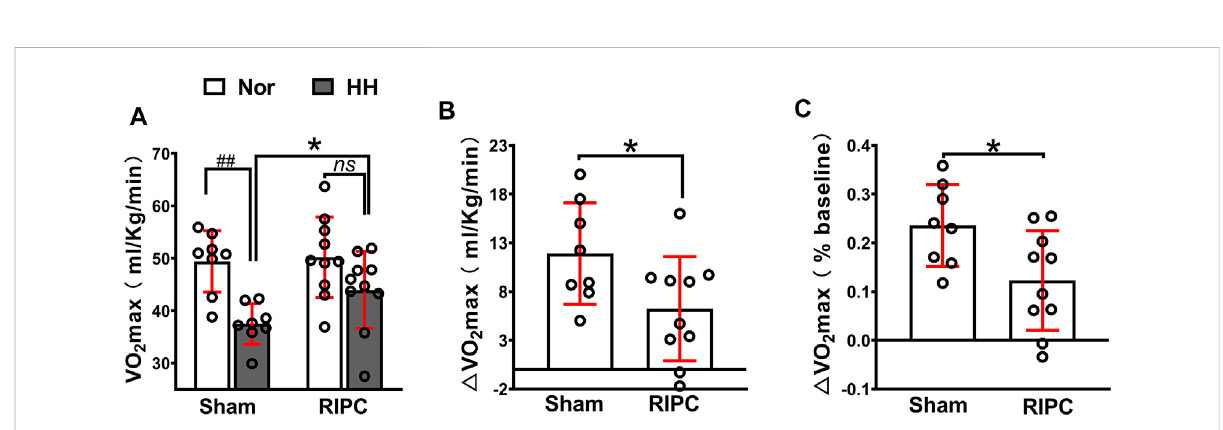
FIGURE 3 Variation ofVO 2 maxintheshamandRIPC groupsundernormoxicandHHconditions. (A) VO 2 maxmeasurement (B) Δ VO 2 maxand (C) percent changesofVO 2 maxfromthenormoxictoHHconditionineachgroup.Valuesarepresentedasmean±standarddeviation. ### p < 0.01vs.normoxic; * p < 0.05, * p < 0.001 vs. sham group. RIPC: remote ischemic preconditioning, Nor: normoxic; HH: hypobaric hypoxia, VO 2 max: maximal oxygen uptake